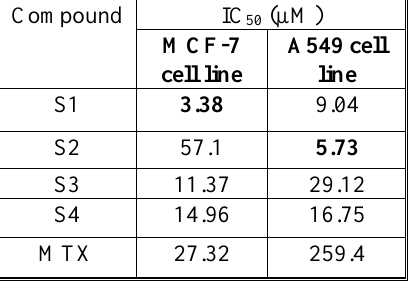
Figure 5. Histogram showing the concentration (µM) and growth inhibition of the tested compounds: Compound S1 (A), Compound S2 (B), Compound S3 (C), and Compound S4 (D) against lung carcinoma cell line (A549). (Values are represented by the mean ± SEM of triplicate measurements). Table 1. In-vitro cytotoxicity evaluation of the synthesized compounds against the selected cancer